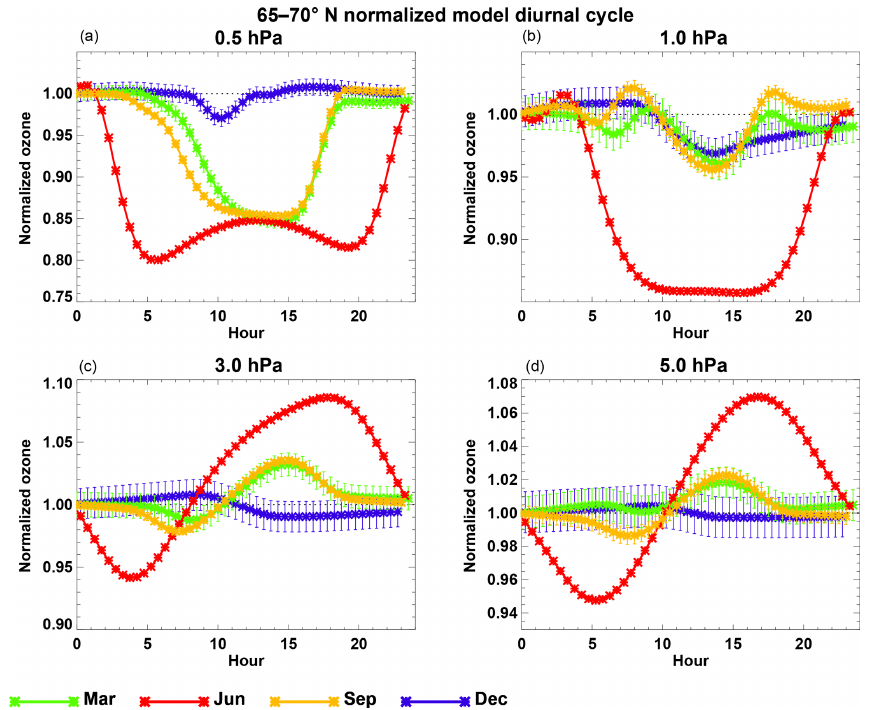
Figure 2. GDOC at 65–70 ◦ N as a function of season at four pressure levels: 0.5hPa (a) , 1hPa (b) , 3hPa (c) and 5hPa (d) . Seasons are represented by monthly output in March, June, September and December. The diurnal signal is plotted as a function of hour (30min resolution) and is normalized to the midnight value. The error bars are 2SEM, as described in the text. The model uncertainty is largest in winter, when the day-to-day and longitudinal variability of model ozone is